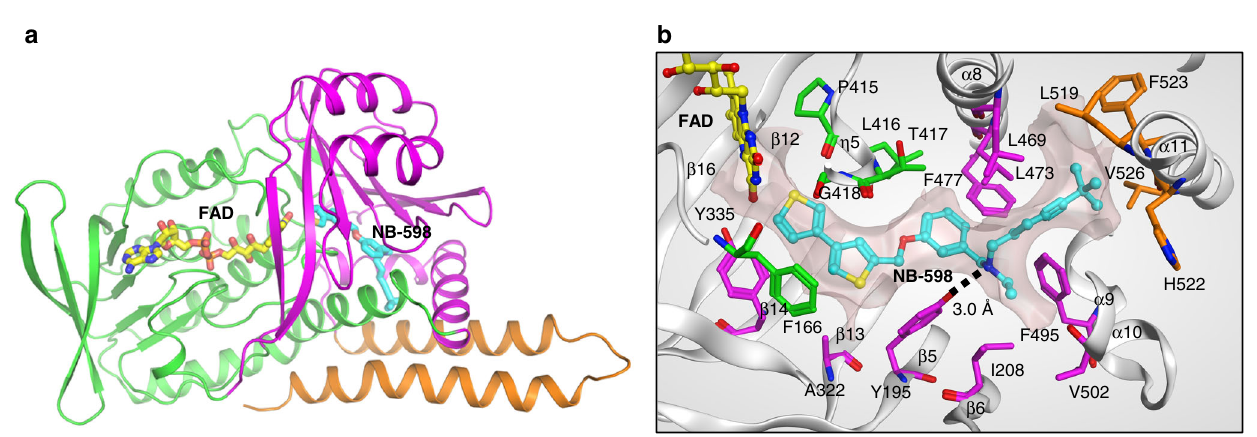
Fig. 2 Human SQLE structure and inhibition. a Overall structure of SQLE bound to inhibitor NB-598. SQLE protein is shown in ribbon representation with the FAD-binding domain in green, the substrate-binding domain in magenta, and the C-terminal membrane – associated helical domain in orange. FAD (yellow) and NB-598 (cyan) are shown as sticks. Hetero-atoms follow the color scheme of yellow, blue, red, and orange for sulfur, nitrogen, oxygen, and phosphor, respectively. b NB-598 binding site. NB-598 and FAD are in ball-and-stick presentation with atomic color scheme as described above. The residues forming the compound binding site is in line presentation with the color scheme on carbon atoms to match the domain coloring scheme as in panel a with important speci fi c residues shown as sticks. The van der waals (VDW) contact surface of the pocket within the 4.5 Å of NB-598 shown as semi-translucent surface. Hydrogen bond interaction between Y195 and the central amine of NB-598 is shown as black dashed line with the